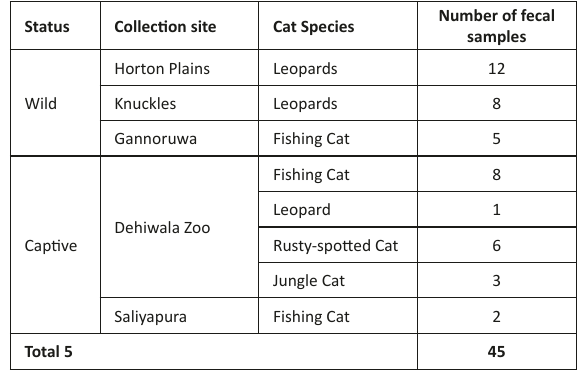
Table 2. Prevalence of infection of gastrointestinal parasites in the four cat species